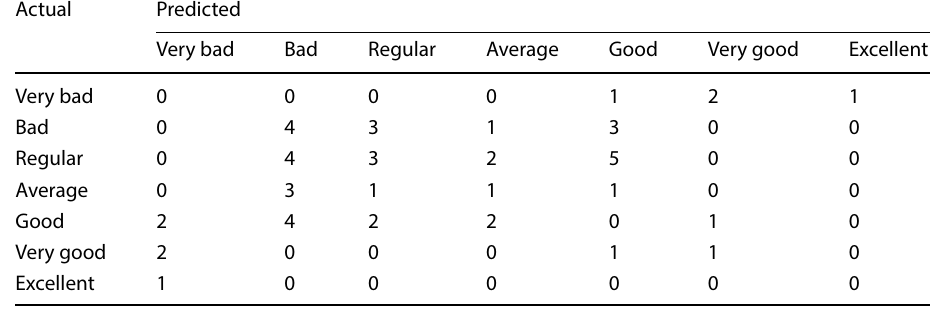
Table 7 Classification confusion matrix via Random Forest algorithm using numerical values as input data for categorical